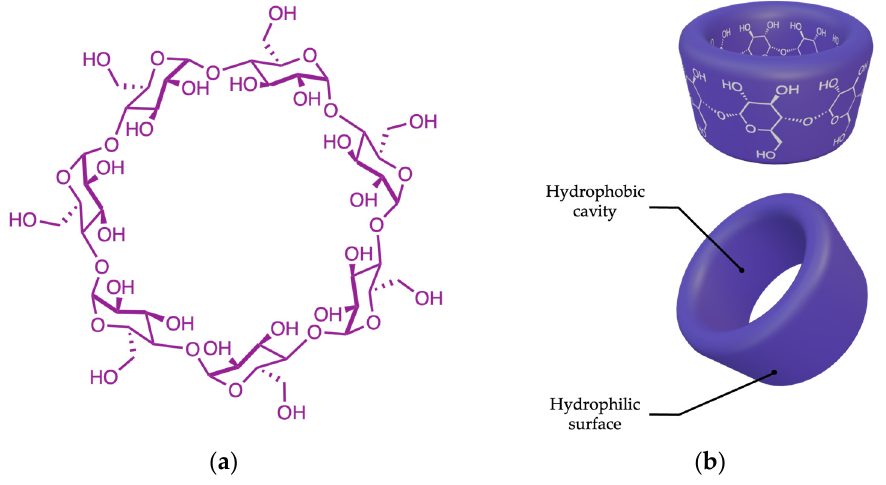
Figure 2. Schematic representations of ( а ) general chemical structure and ( b ) 3D structure of β -CD. The most common CDs, otherwise known as parent CDs, consist of six ( α -CD), seven ( β -CD), or eight ( γ -CD) glucopyranose rings. The difference in the sizes of the inner cavity in the parent CDs steers them towards guest molecules with appropriate sizes and